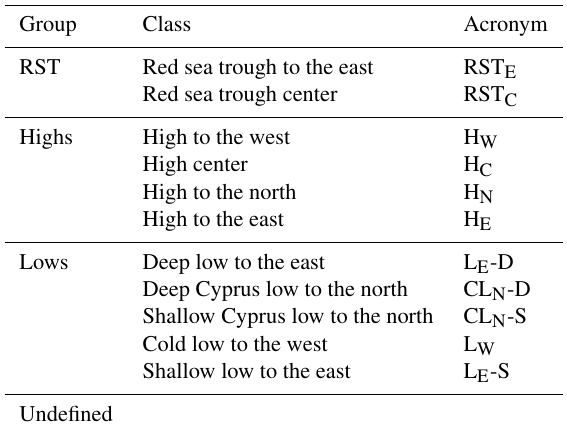
Table 1. The winter synoptic groups and